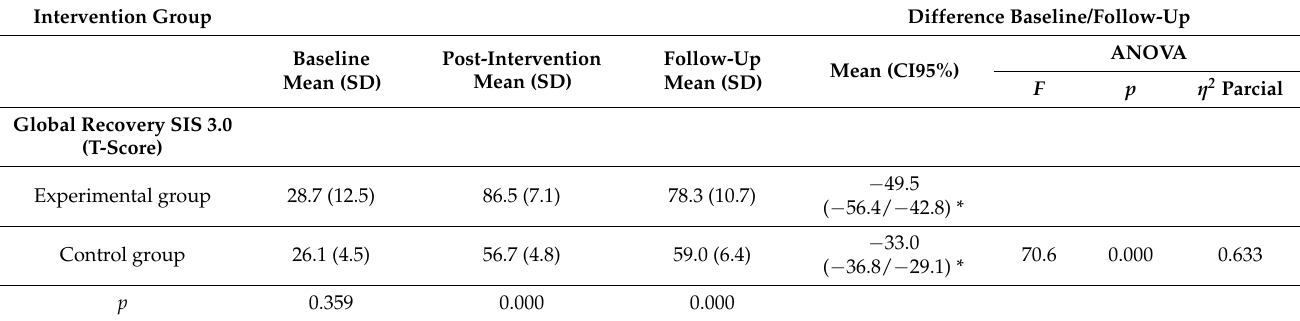
Table 5. Linear model. Effect of the intervention on global recovery from stroke (SIS 3.0). Intervention Group Intervention